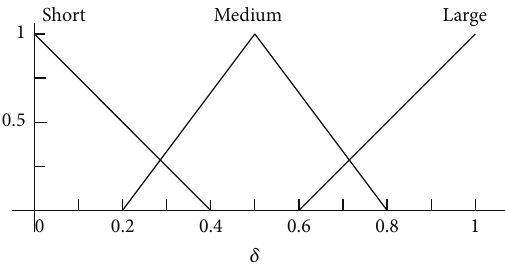
Figure 3: Fuzzy membership function for input 𝛿